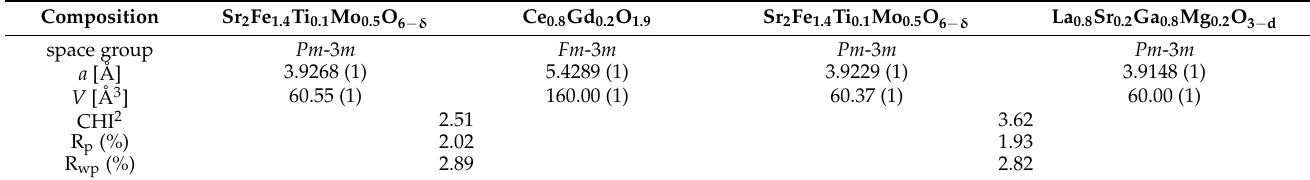
Table 5. Structural parameters of Sr 2 Fe 1.4 Ti 0.1 Mo 0.5 O 6 − δ sample with Ce 0.8 Gd 0.2 O 1.9 and